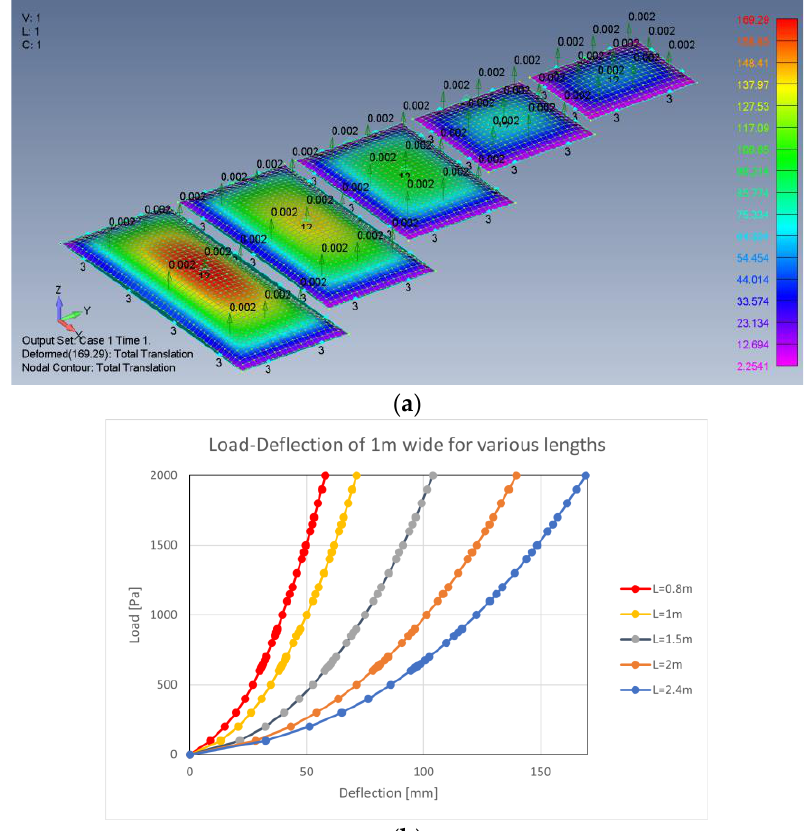
Figure 3. FEA deformation map ( a ) and load – deflection curves ( b ).